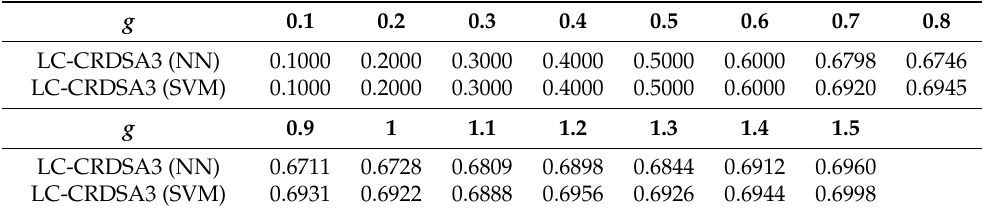
Table 2. Throughput of LC-CRDSA3 at different average data generation